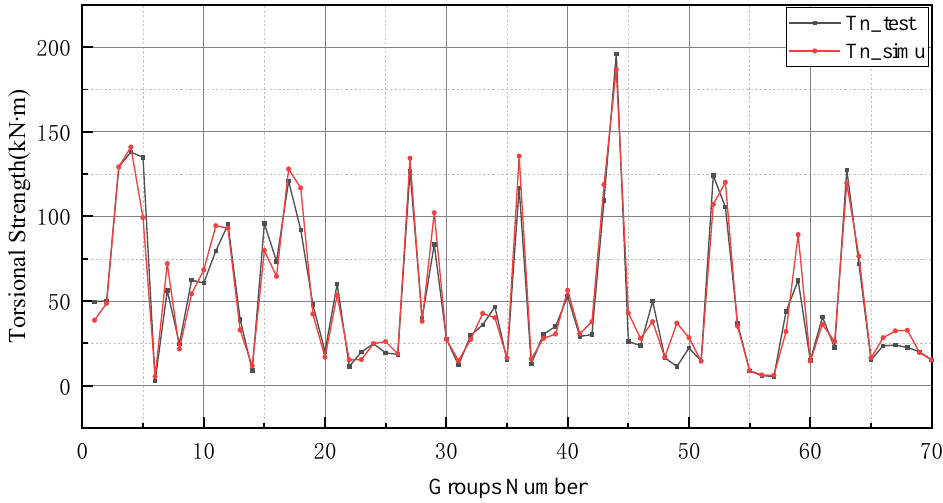
Figure 7. BP neural network optimized by k-fold cross-validation.